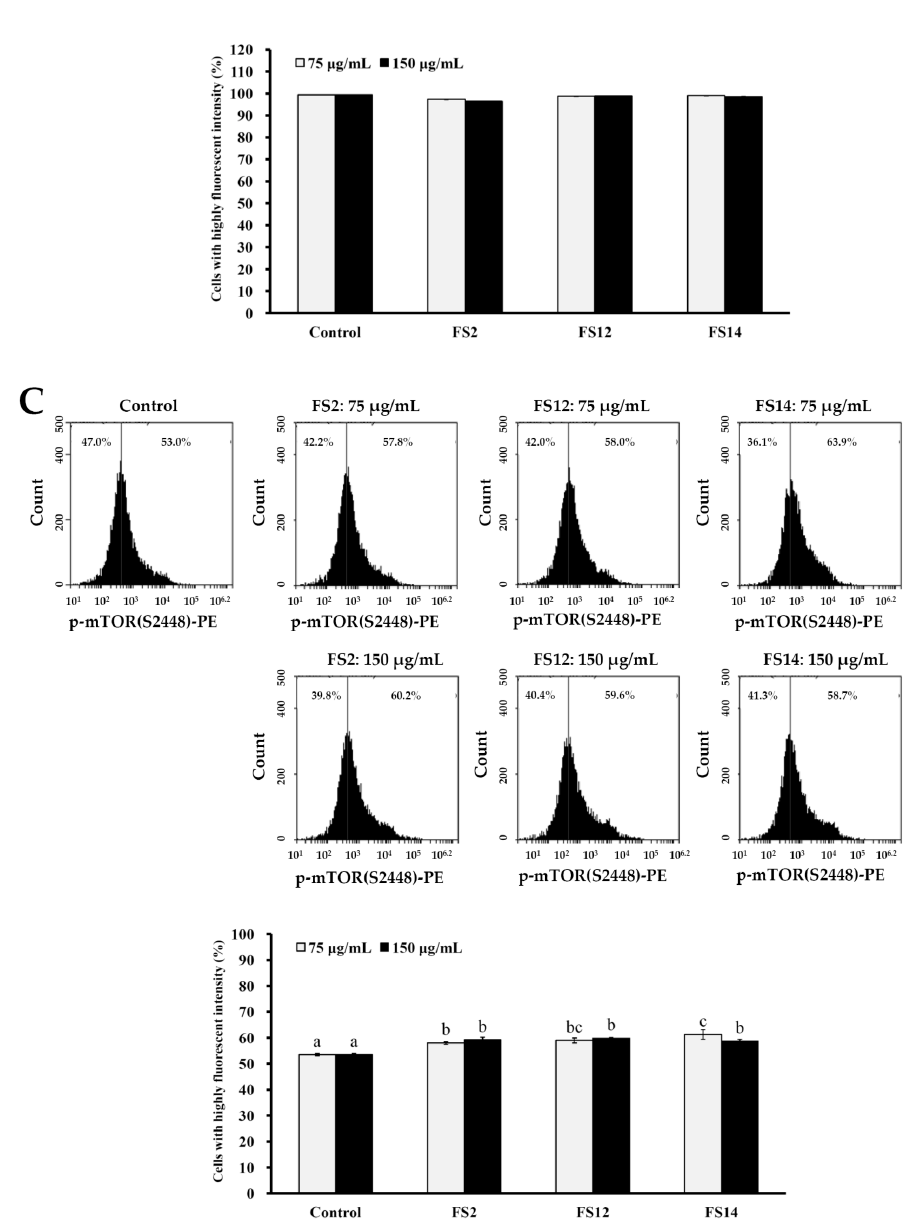
Figure 6. Effects of various concentrations (75 and 150 µ g/mL) of FS2, FS12, and FS14 on the expressions of p-Akt, Akt1, and p-mTOR in HaCaT cells: ( A ) HaCaT cells were pretreated with FS2, FS12, or FS14 at a concentration of 75 or 150 µ g/mL for 6 h, and fluorescence histograms of immunolabeled p-Akt were assessed. Bar graph summarized three cell cytometric analyses showing the percentages of cells with highly fluorescent intensity according to treatments. ( B ) HaCaT cells were pretreated with FS2, FS12, or FS14 at a concentration of 75 or 150 µ g/mL for 6 h, and fluorescence histograms of immunolabeled Akt1 were assessed. The bar graph summarizes three cell cytometric analyses showing the percentages of cells with highly fluorescent intensity according to treatments. ( C ) HaCaT cells were pretreated with FS2, FS12, or FS14 at a concentration of 75 or 150 µ g/mL for 6 h, and fluorescence histograms of immunolabeled p-mTOR were assessed. The bar graph summarizes three cell cytometric analyses showing the percentages of cells with highly fluorescent intensity according to treatments. The data are represented as means ± SD ( n = 3). Different letters (in a, b, and c) upon bars indicate significantly different ( p < 0.05).